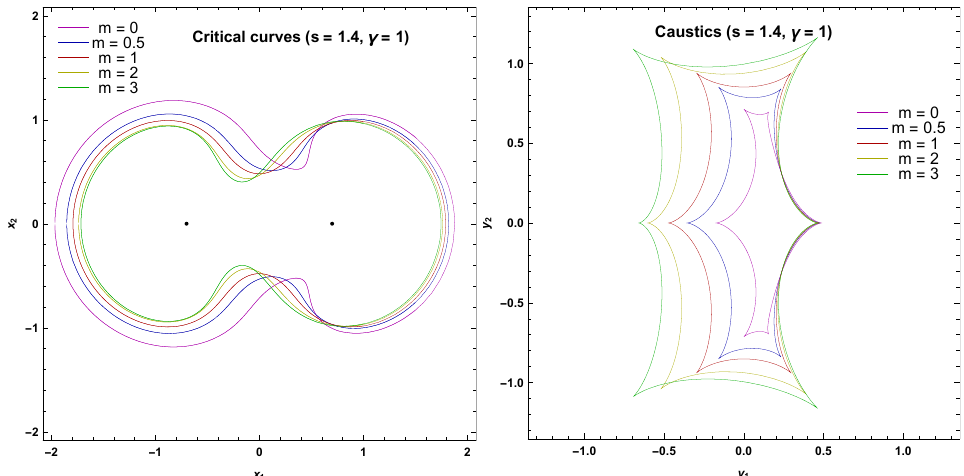
Figure 3. Critical curves and caustics in the equal-strength binary, intermediate separation.